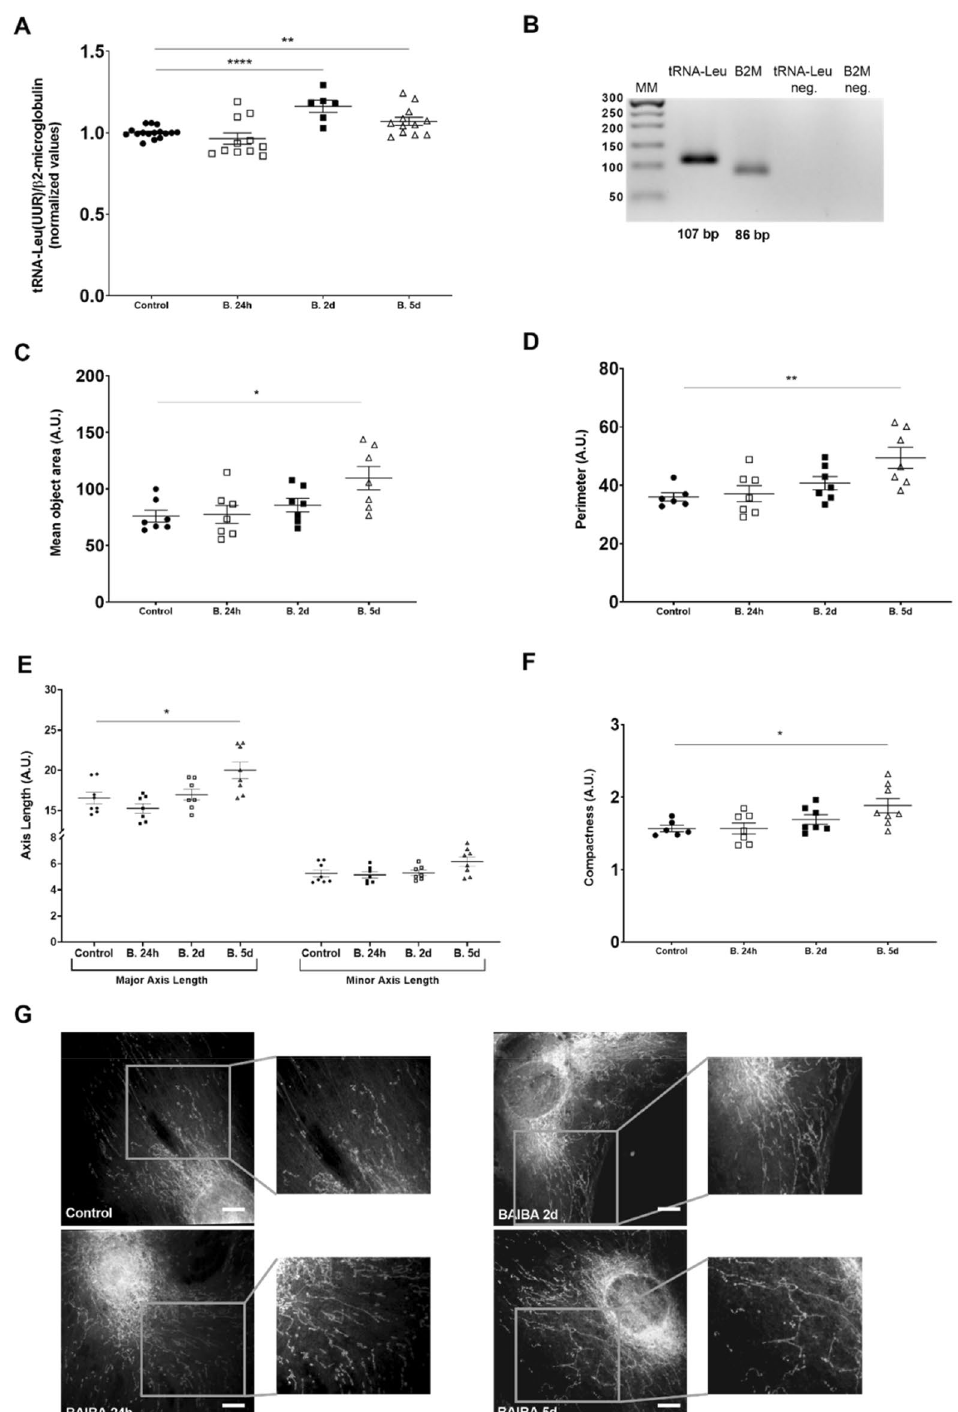
Figure 3. L-BAIBA promotes mitochondrial enlargement and branching in podocytes. ( A ) L-BAIBA treatment (10 µM; 24 h, 2 days, and 5 days) influenced mtDNA levels in podocytes. n = 6–16. ** p < 0.01, **** p < 0.0001. ( B ) Representative agarose gel showing PCR products. ( C ) Mean mitochondrial area (total number of pixels in the object) in podocytes after L-BAIBA treatment. n = 7. * p < 0.05. ( D ) Mitochondrial perimeter (number of pixels that formed the boundary of an object) in podocytes after L-BAIBA treatment. n = 6–7. ** p < 0.01. ( E ) L-BAIBA affected major axis length (pixel distance between endpoints on the longest line that could be drawn through the object) and minor axis length (longest line that could be drawn through the object while remaining perpendicular to the major axis) of mitochondria in podocytes. n = 7–8. * p < 0.05. ( F ) L-BAIBA affected mitochondrial compactness ([perimeter] 2 / [4π × area]). n = 6–8. * p < 0.05. ( G ) Confocal images of podocyte mitochondria after L-BAIBA treatment. Scale bar = 10